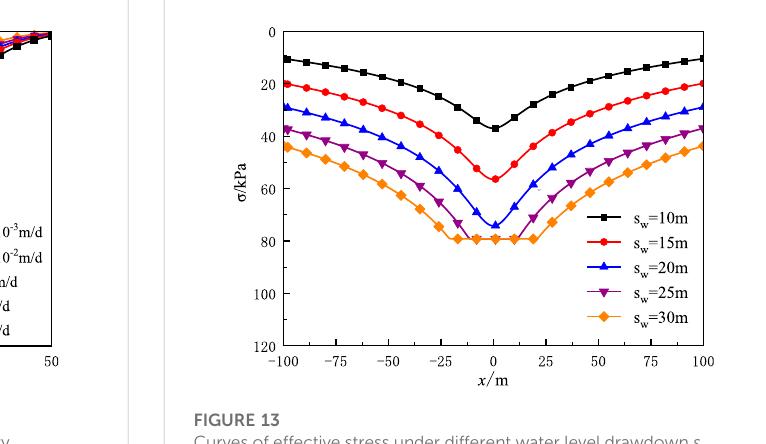
FIGURE 11 Curves of tunnel displacement under different permeability coef fi cients of soil k t.